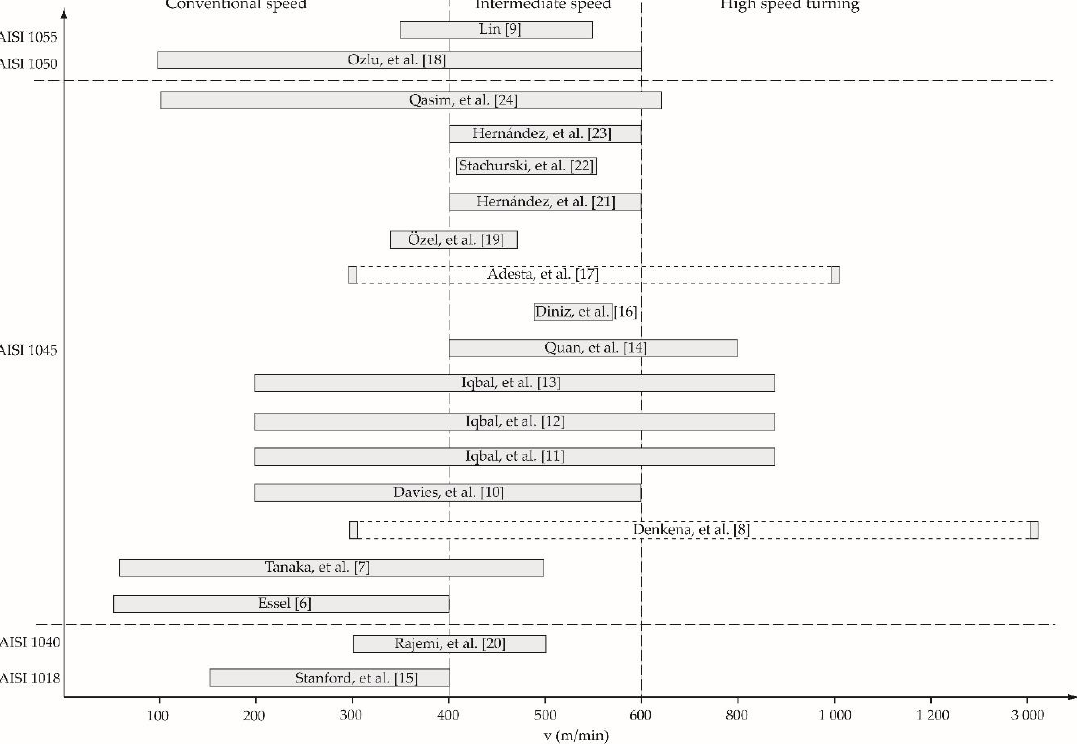
Figure 1. Main investigations in the high-speed turning of plain carbon steel.